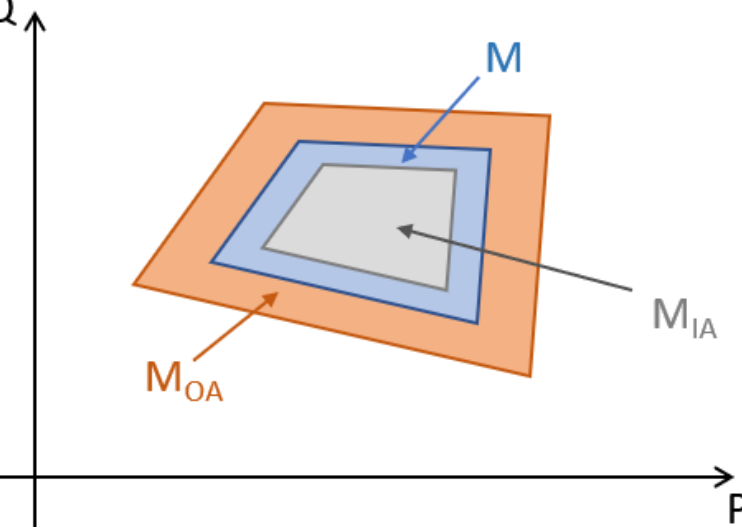
Figure 4. Visual comparison of the M-sum, the IA of the M-sum and the OA of the M-sum.